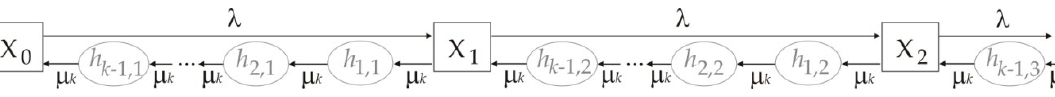
Figure 5. Queueing system M( λ )/E k ( μ )/ ∞ .